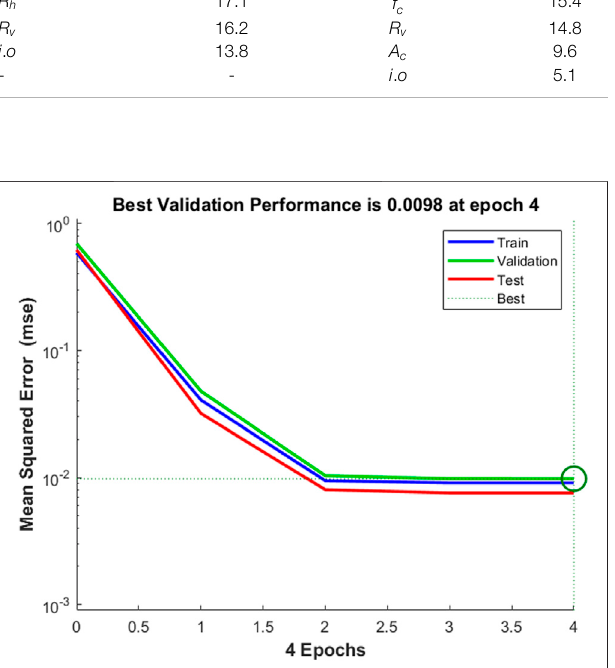
TABLE 5 | Connection weights and biases of hidden and output layers of the N5- 6-1 model.